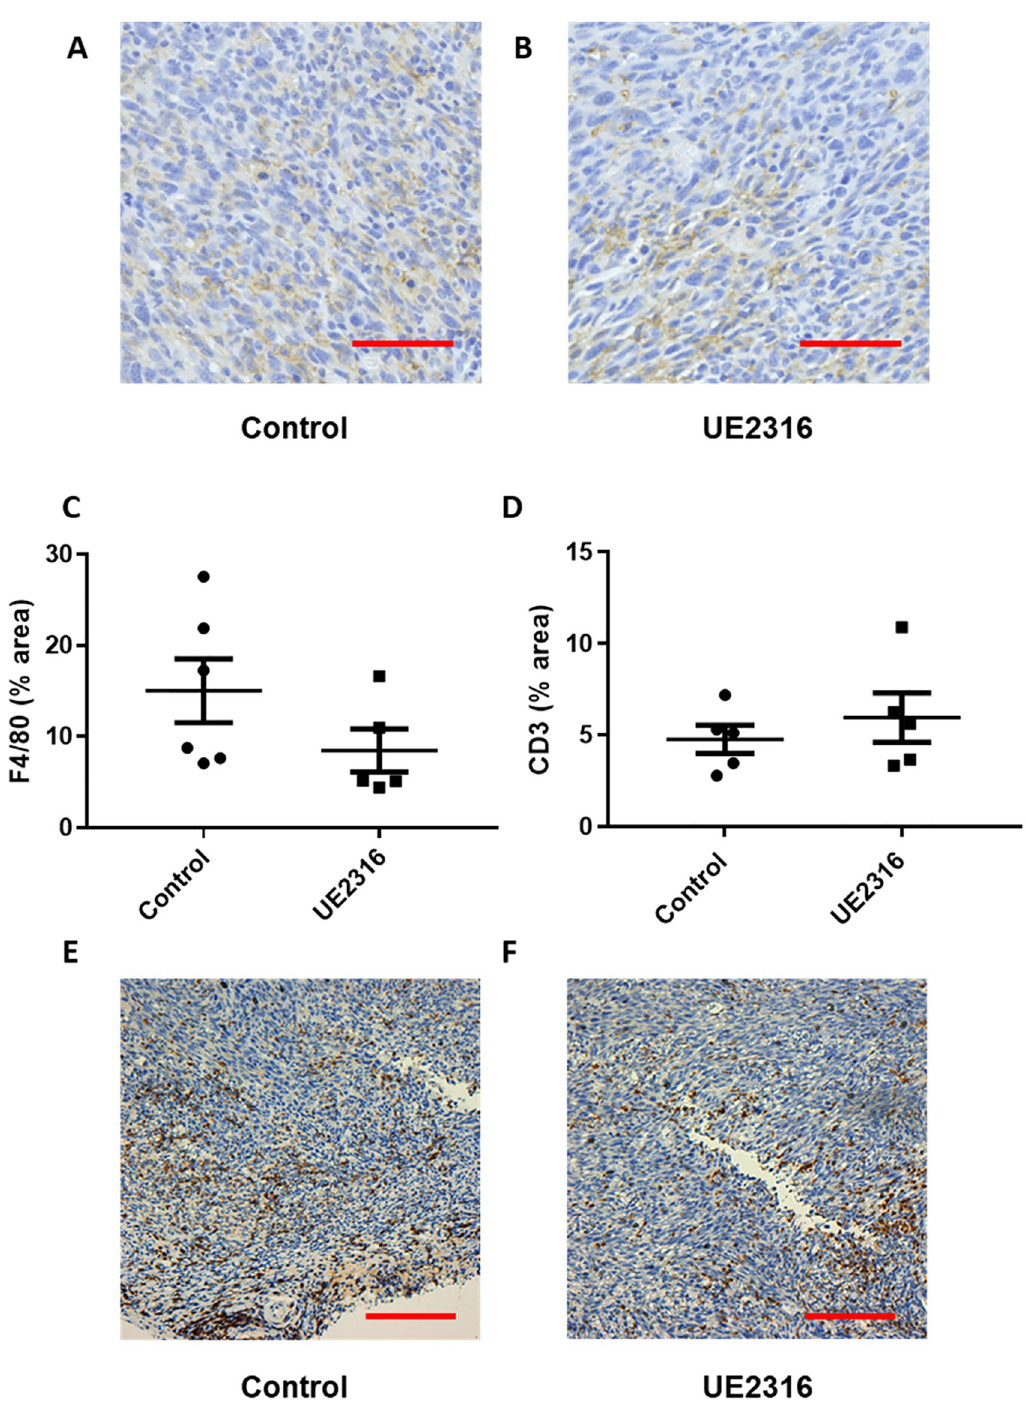
Fig 5. F4/80 and CD3 positive cell number in SCC tumours were unaffected by UE2316. Representative images of squamous cell carcinoma (SCC) tumours from control (A) and UE2316-treated (B) mice are shown, with DAB immunoreactivity to anti- F4/80 antibody shown in brown and haematoxylin-counterstained nuclei in blue. C) Immunostaining did not reveal a difference in F4/80-positive stain area between tumour from control and UE2316-treated mice (P = 0.17). N = 5-6/group. Data were compared by independent samples t-test. Scale bar = 50 μ m. Immunostaining found no difference in CD3-positive stain area between SCC tumours from control and UE2316-treated mice, assessed by whole section analysis. N = 5/group (D). Representative images of CD3 labelled SCC tumour sections from control (E) and UE2316-treated (F) squamous cell carcinoma (SCC). DAB immunoreactivity shown in brown and haematoxylin-counterstained nuclei in blue. Data were compared by independent samples t-test, N =